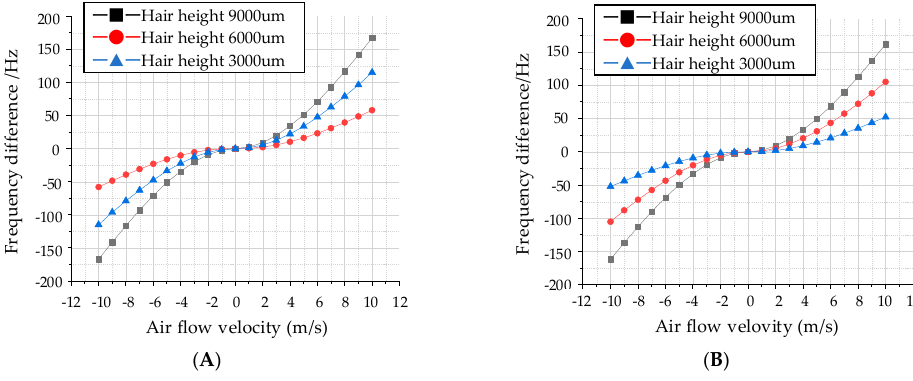
Figure 4. Relationship between output frequency and air flow velocity. ( A ) Output frequency difference in x-axis. ( B ) Output frequency difference in y-axis. The cross-axis coupling derived from the orthogonal error is the main obstacle that limits the accuracy of the proposed biaxial sensor. As shown in Figure 5, when the flow velocity acts in the x- axis direction, the simulated x-axis maximum sensitivity to air flow with a 9000 µm hair height is 1.69 Hz/(m/s) 2 and the corresponding y-axis sensitivity is 0.058 Hz/(m/s) 2 , which indicates a coupling coefficient of 0.033 in the x-axis. Similarly, a coupling coefficient of 0.025 is simulated in the y-axis. Therefore, the influence of cross-axis coupling can be ignored.